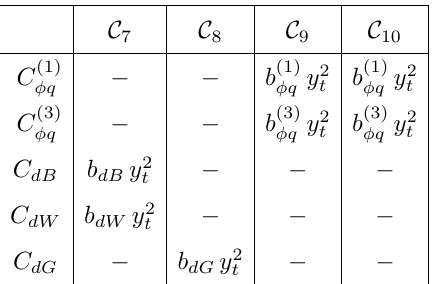
) to the WET coefficients C ( m ) . Effects Z Z , which first appear at a 0